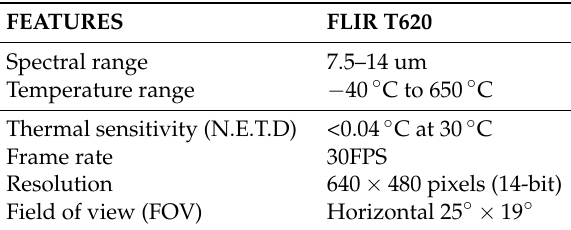
Table 1. IR camera sensor specification.